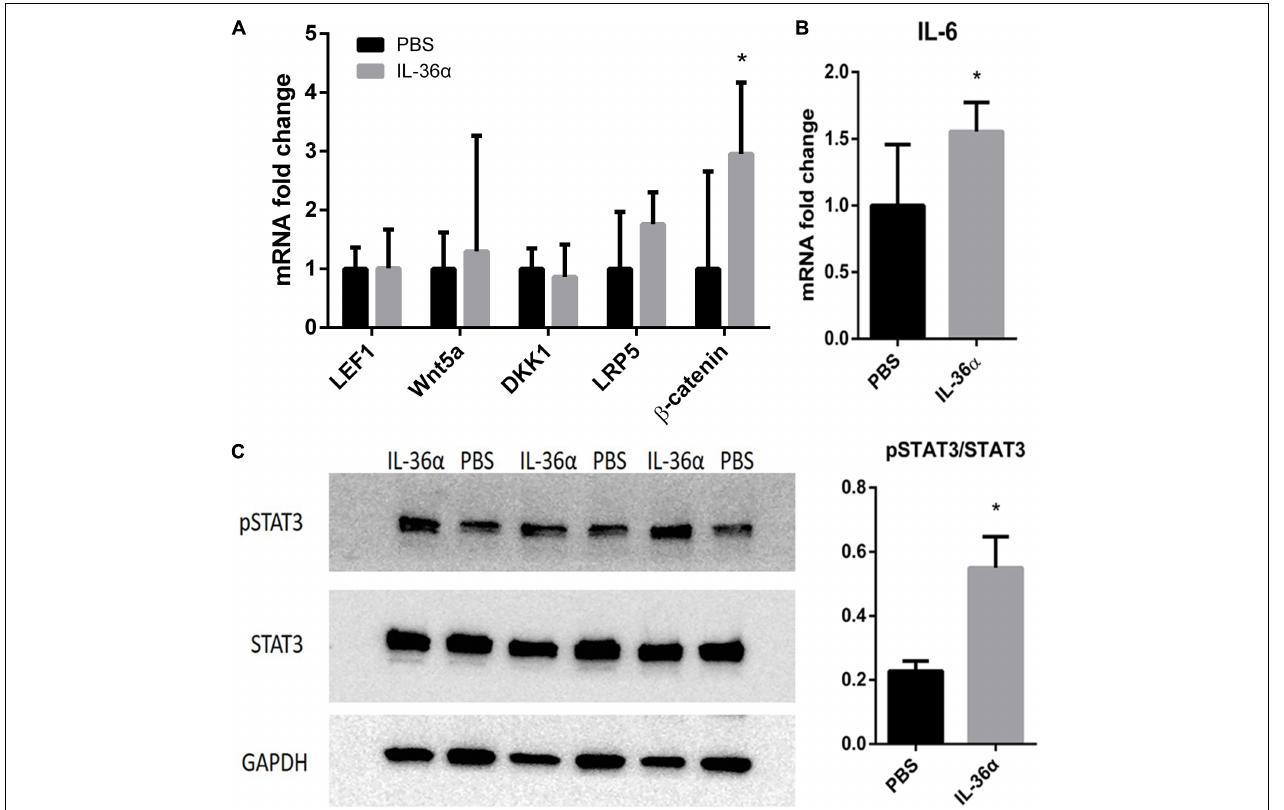
FIGURE 5 | mrIL-36 α causes increased expression level of β -catenin and IL-6 and activates STAT3. A total of 50 µ L of 1 ng/ µ L mrIL-36 α dissolved in PBS or PBS only was injected intradermally into two separate dorsal regions of skin of 7-week-old mice for 3 days. (A,B) Total mRNA was isolated from mrIL-36 α -injected region and control region, and mRNA levels of LEF1, Wnt5a, DKK1, LRP5 , β -catenin (key genes in Wnt/ β -catenin pathway) and IL-6 were analyzed by qPCR ( n = 4). (C) The phosphorylation level of STAT3 in the IL-36 α -treated region and the control region analyzed by western blot (* p < 0.05, n =